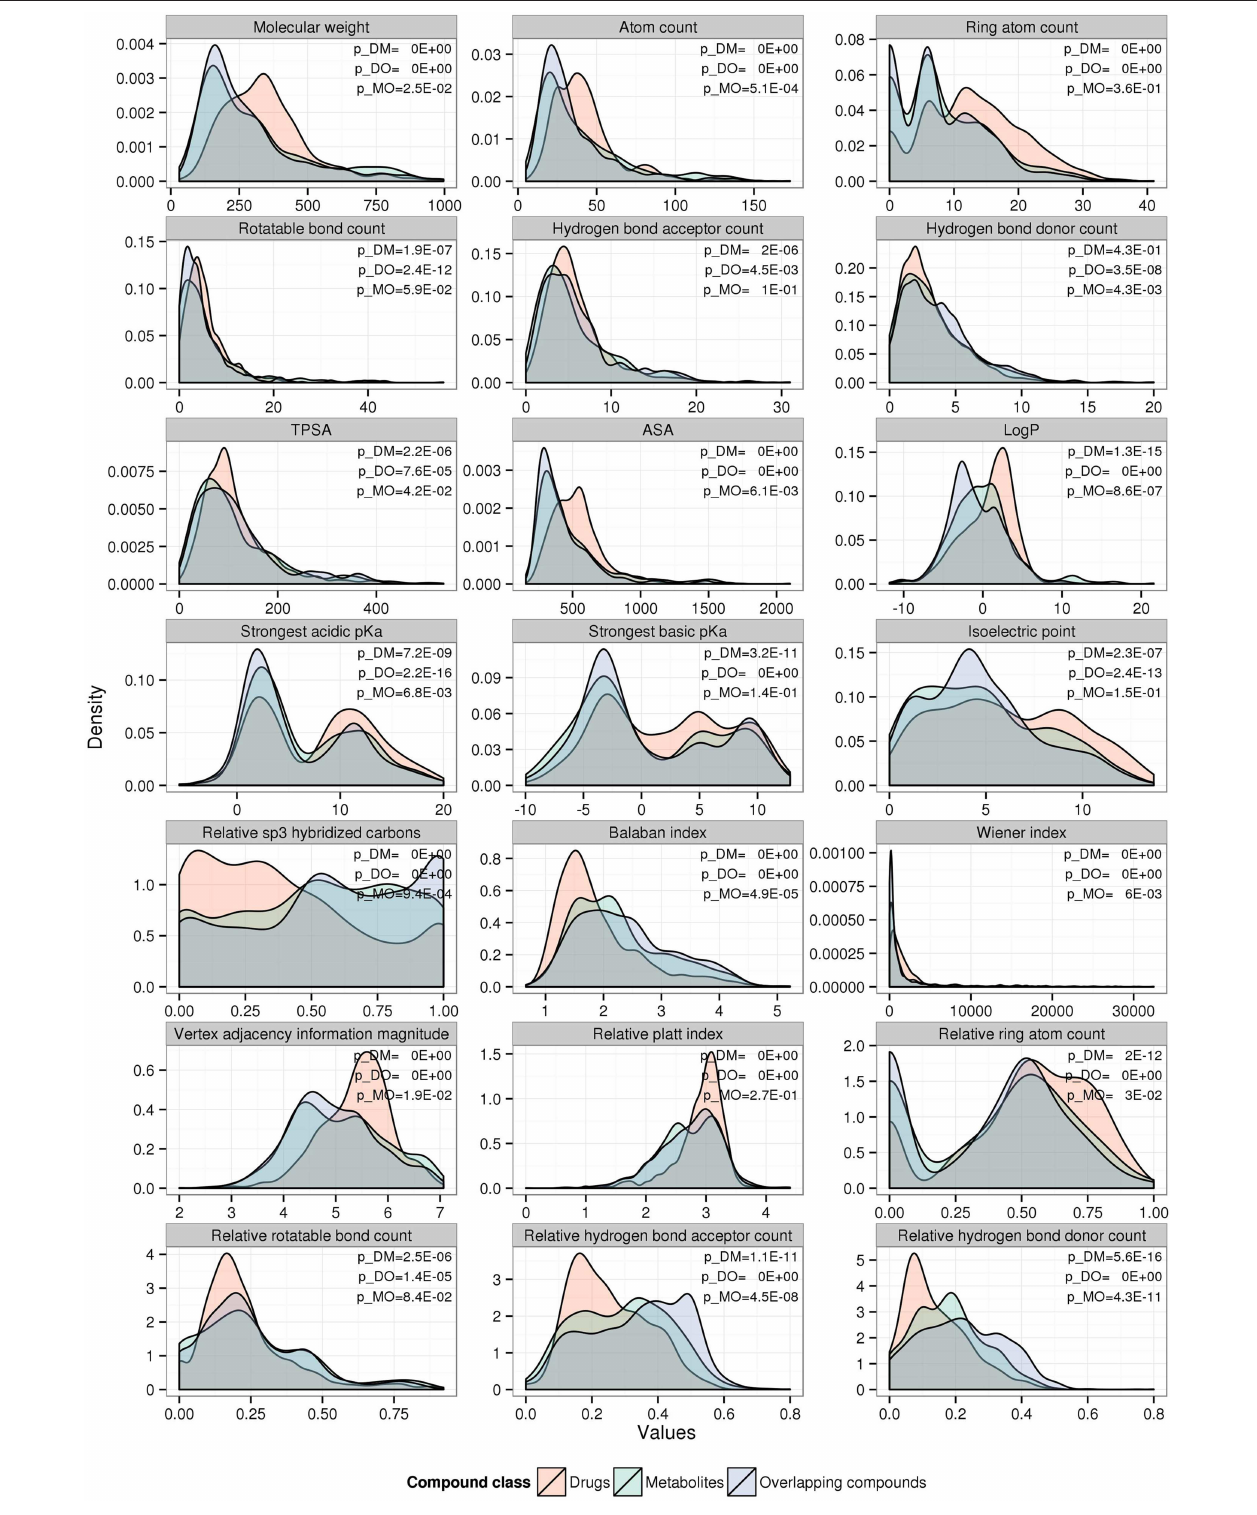
FIGURE 1 | Compound-class specific density distributions of various physicochemical properties. The density plots were generated separately for drugs (red), metabolites (green), and overlapping compounds (blue). Statistical significance ( p -value) was computed for drugs vs. metabolites (p_DM), drugs vs. overlapping compounds (p_DO), and metabolites vs. overlapping compounds (p_MO) by Kolmogorov–Smirnov test.